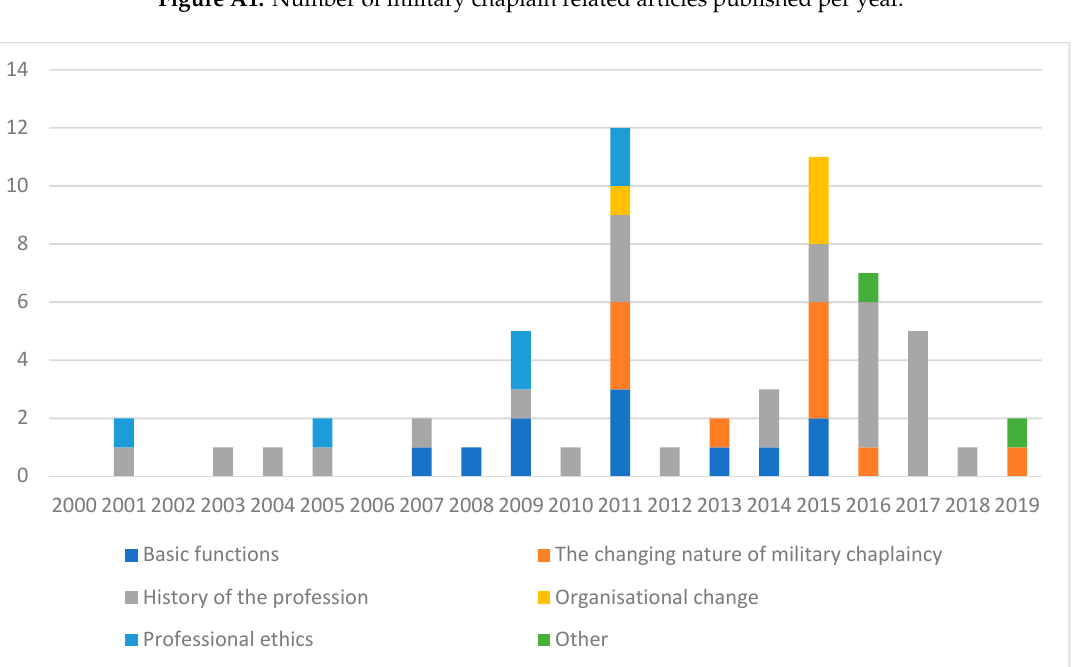
Figure A1. Number of military chaplain related articles published per year.